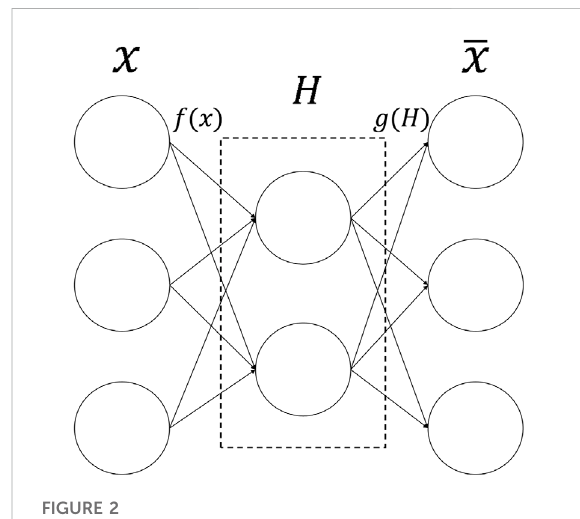
FIGURE 2 The structure of Autoencoder. The input data is fi rst encoded by the encoder, then embedded in the hidden layer, and fi nally output by the decoder.